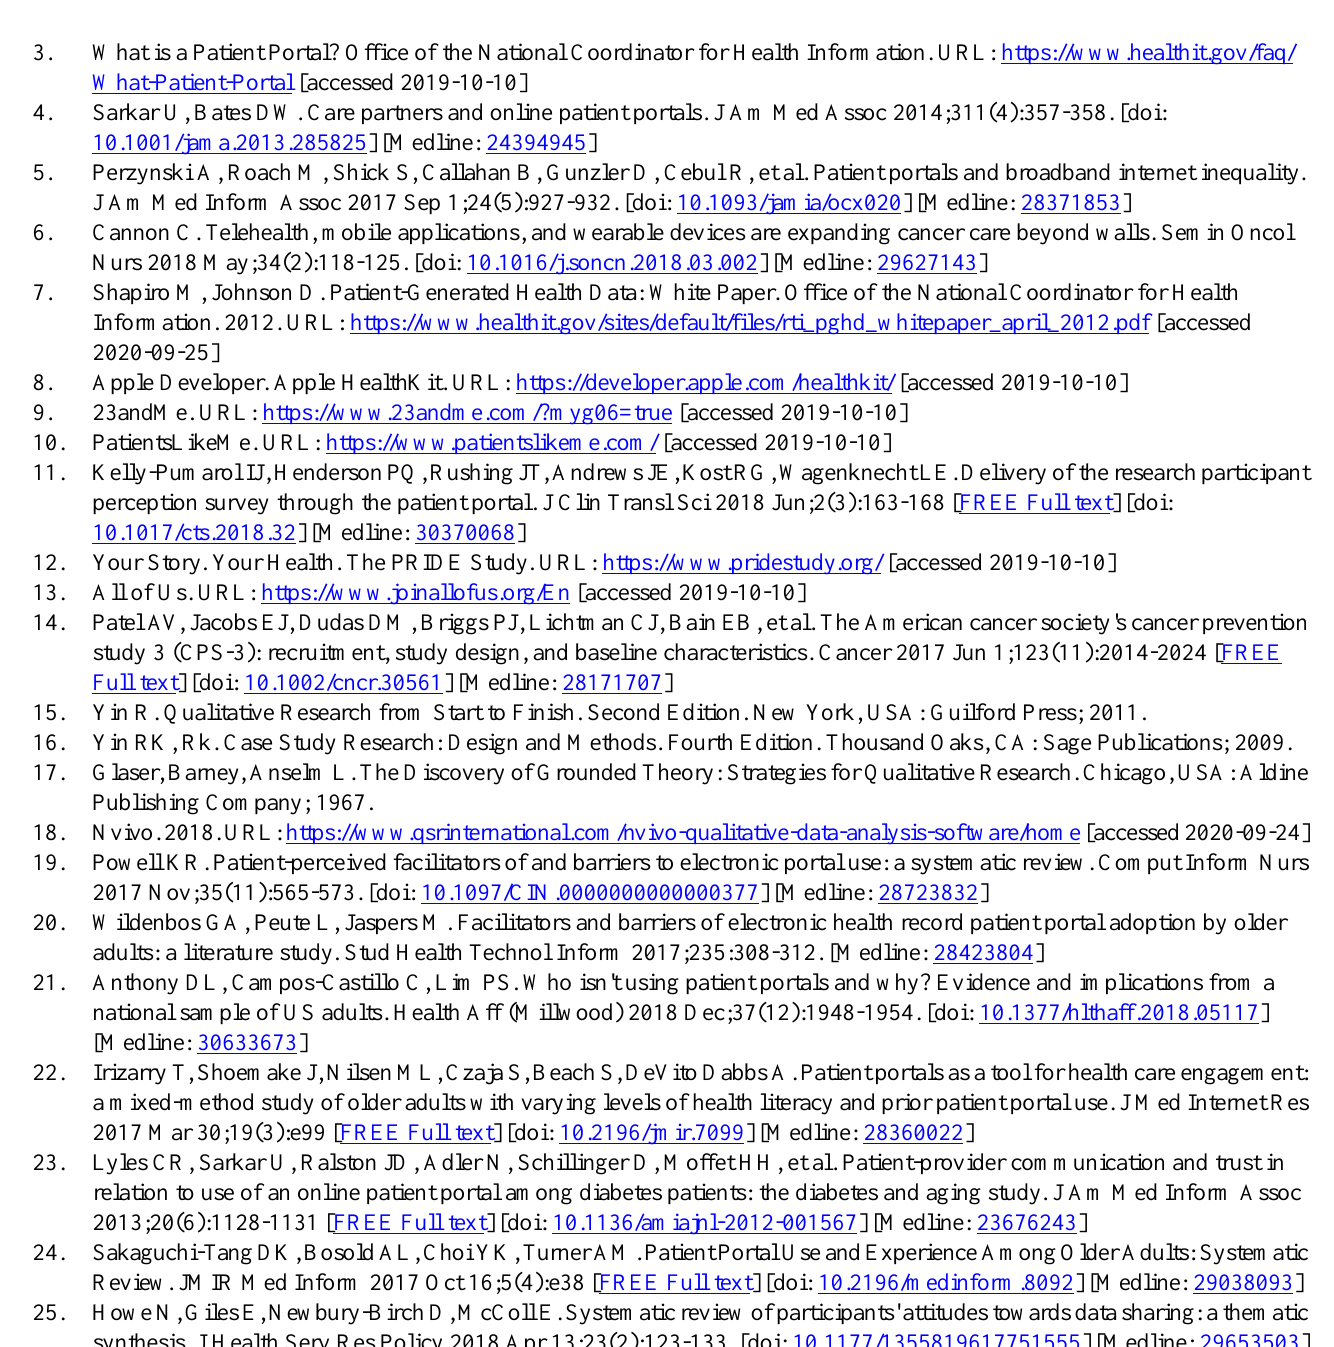
PGHD: patient-generated health